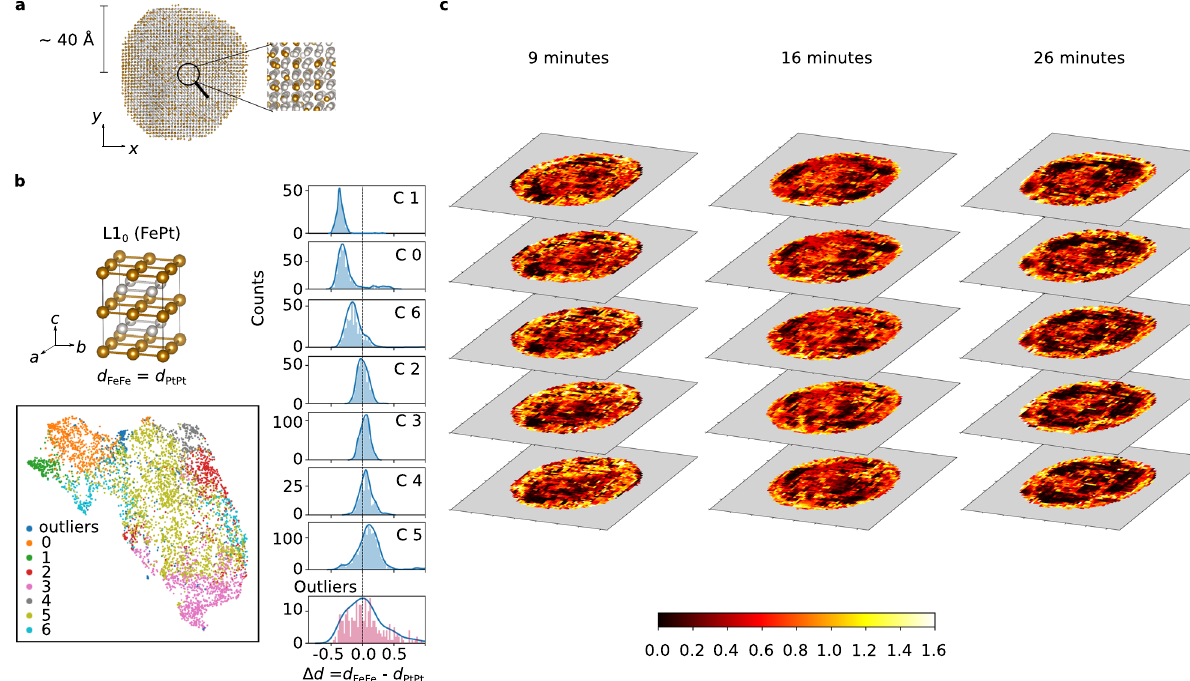
Fig. 4 Analysis of atomic electron tomography data. a Side view of FePt nanoparticle (~23 k atoms), with atomic positions and chemical species from atomic electron tomography (AET) data 61 . b Two-dimensional projection (bottom left) of neural-network representations ( fi rst hidden layer) via UMAP for regions classi fi ed as L1 0 by ARISE. The distribution of the difference between the nearest neighbor distances d FeFe and d PtPt (highlighted by bonds in top left part) is shown for each cluster (right), where cluster i = 0, . . . , 6 is denoted as Ci, while all points for which HDBSCAN does not assign a cluster are labeled as outlier. c Five central slices (mutual information, obtained via strided pattern matching) for three different annealing times (data from four-dimensional AET experiment 62